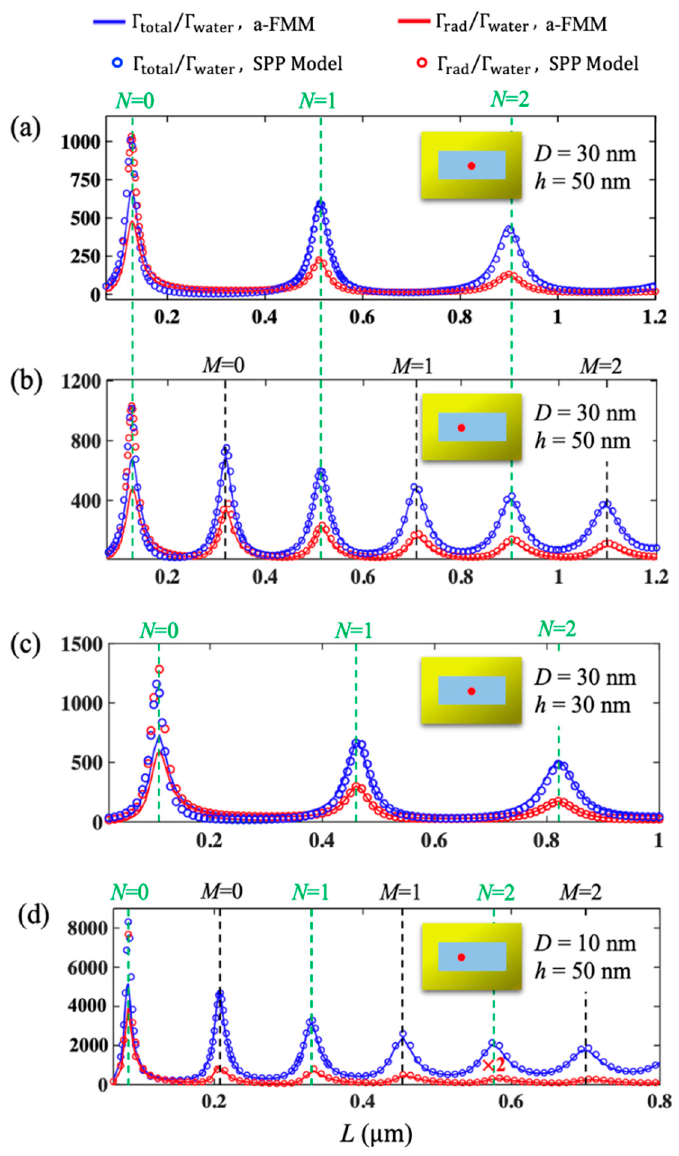
Figure 2. Normalized total and radiative emission rates (i.e., enhancement factors) Γ total / Γ water (blue curves) and Γ rad / Γ water (red curves) plotted as functions of the antenna length L at an excitation wavelength λ = 1 µ m. The solid curves and circles show the full-wave a-FMM results and SPP model predictions, respectively. The green and black vertical dashed lines show the aperture lengths determined by Equations (14) and (15), respectively. ( a , c ) The point source is at the center of the aperture, the aperture width is D = 30 nm and the aperture depth is h =50 nm ( a ) and 30 nm ( c ). ( b , d ) The distance from the point source to the left end of the aperture is d = 63 nm, D = 30 nm ( b ) and 10 nm ( d ) and h = 50 nm. The value of Γ rad in ( d ) is multiplied by 2 for a clear